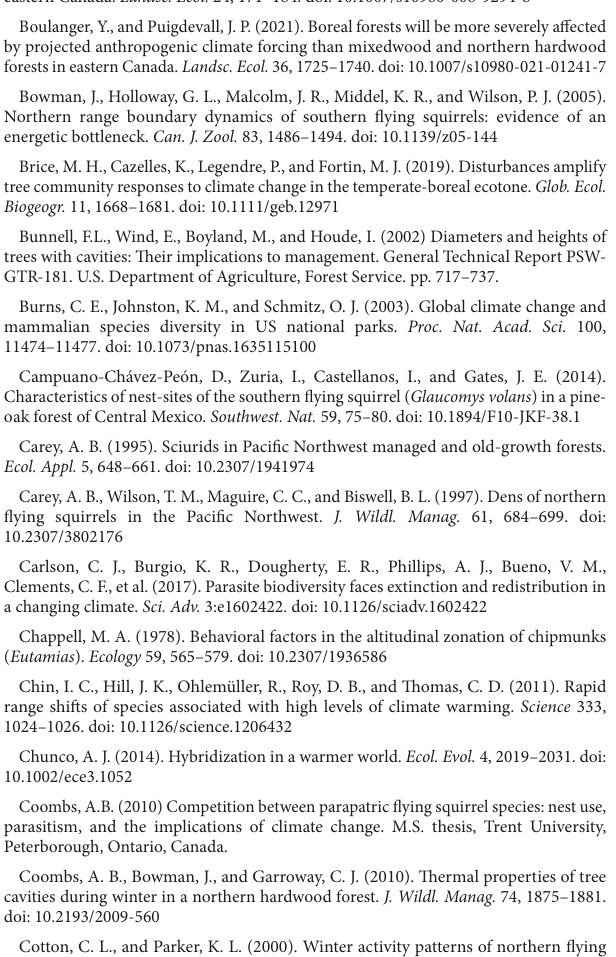
Peterborough, Ontario,